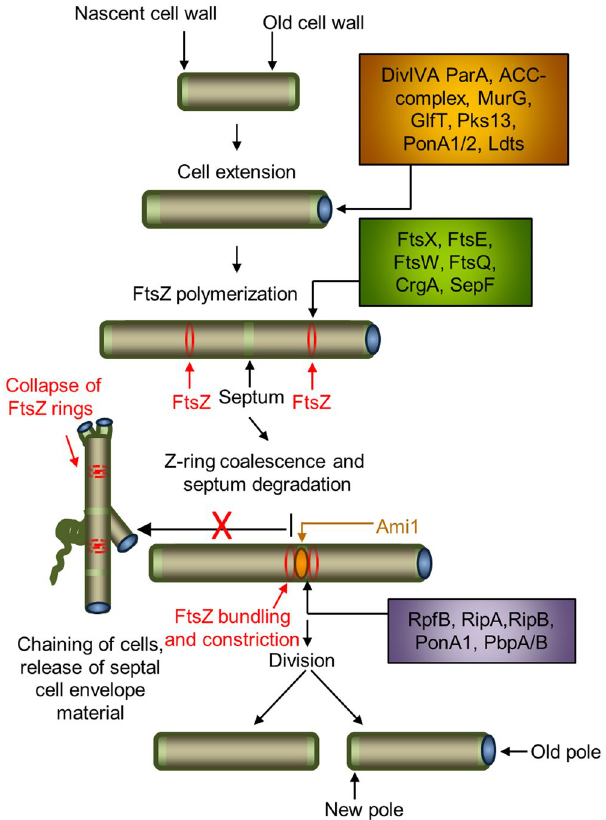
Figure 10. Proposed model for amidase function in mycobacteria. Mycobacterial cell division requires remodelling of the cell wall in two distinct regions namely the polar annular region and the septum. Shown are proteins associated with cell surface restructuring at the pole (orange box) and the septum (purple box). Proteins involved in FtsZ landing, polymerization and bundling are shown in the green box. Ami1 is required for septal cleavage. Deletion of ami1 results in the formation of cell chains, which are thinner than wild type bacteria, with aberrant cell growth/division modalities such as Y-form cell growth and lateral budding. Ectopic polar growth and lateral budding is mediated by mislocalization of the cell extension machinery. Defective division in cell chains also results in destabilization of FtsZ polymers and dysregulation of septal cell wall